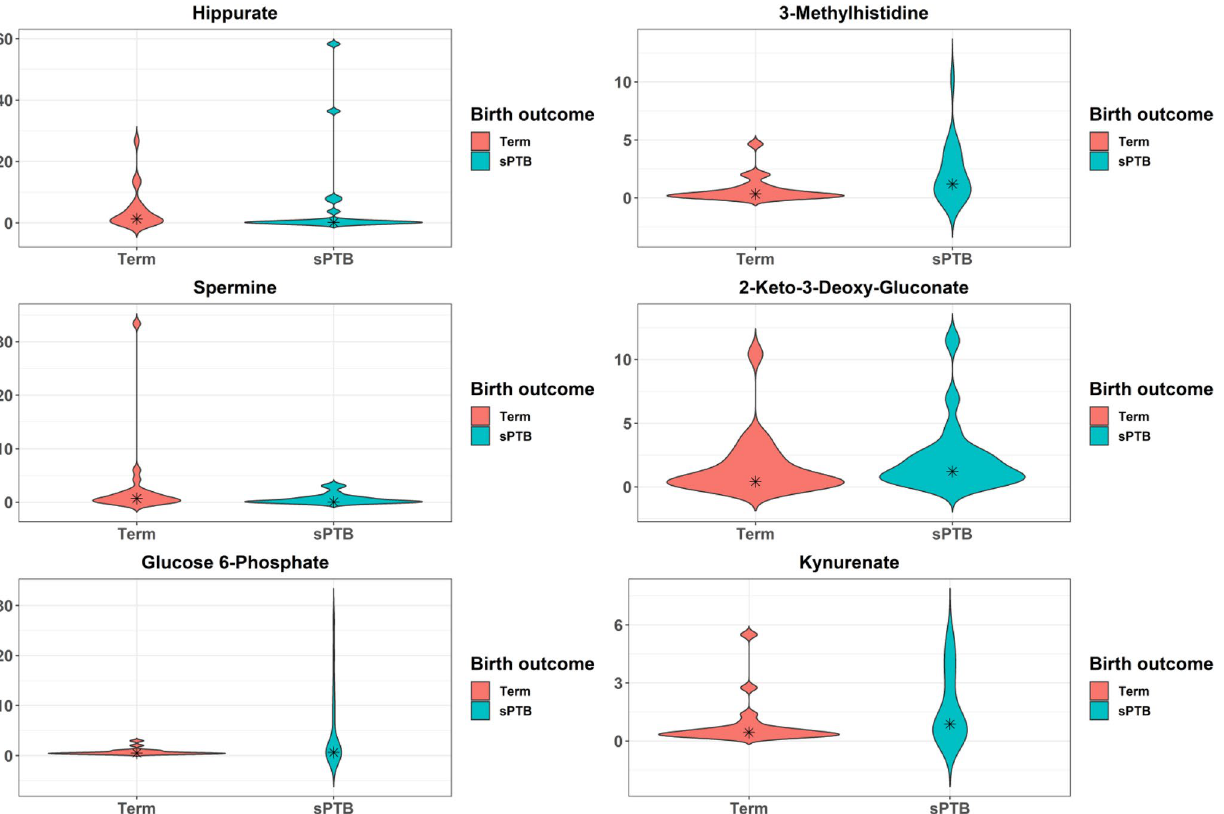
Figure 6. Violin plots of metabolites among CST IV that differed by birth outcome. Kernel probability density of various metabolites are presented. Metabolite abundances were log2 transformed and two-sided Student t-tests were performed. Resulting p-values were corrected by false discovery rates calculated using the Benjamini–Hochberg (BH) method with a threshold of ≤ 0.1. Fold change was calculated to quantify the difference in log2 change between groups for each metabolite. Metabolites with a p-value ≤ 0.05 and absolute fold changes ≥ 1.5 were considered significant. Violin plots are presented for the top six metabolites with the greatest fold